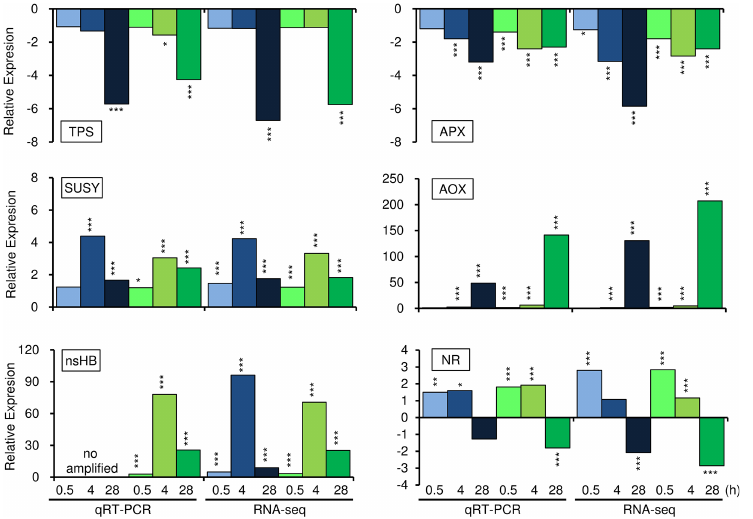
Fig 2. Validation of pairwise RNA-seq data through qRT-PCR. Six hypoxia-responsivegenes (TPS: Trehalose-6-Phosphate Synthase, Glyma17g07530;APX: AscorbatePeroxidase, Glyma12g07780;SUSY: Sucrose Synthase, Glyma13g17420;AOX: AlternativeOxidase, Glyma04g14800;nsHB: non-symbiotic Hemoglobin, Glyma11g12980; and NR: Nitrate Reductase,Glyma06g11430) were analyzedin flood-tolerant Embrapa 45 (Blue chart) and flood-sensitive BR 4 (Green chart) soybeancultivars. The transcripts abundance of the target genesfrom plants subjectedto hypoxic conditions for different periodsof time were comparedwith the respectivecontrols (normoxiccondition).Differential gene expressionstatistically significant: * p < 0.05, ** p < 0.01, and *** p < 0.001. From qRT-PCR, raw data was normalized using the ELF1B and ACTB reference genes[17]. The no qRT-PCR amplification of Glyma11g12980is clarified in Fig B in S1 SupportingInformation.